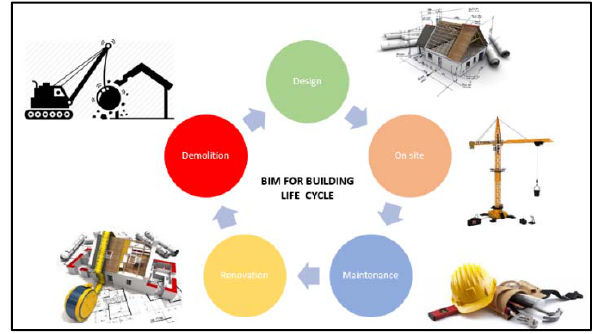
Figure 1. BIM and Building life